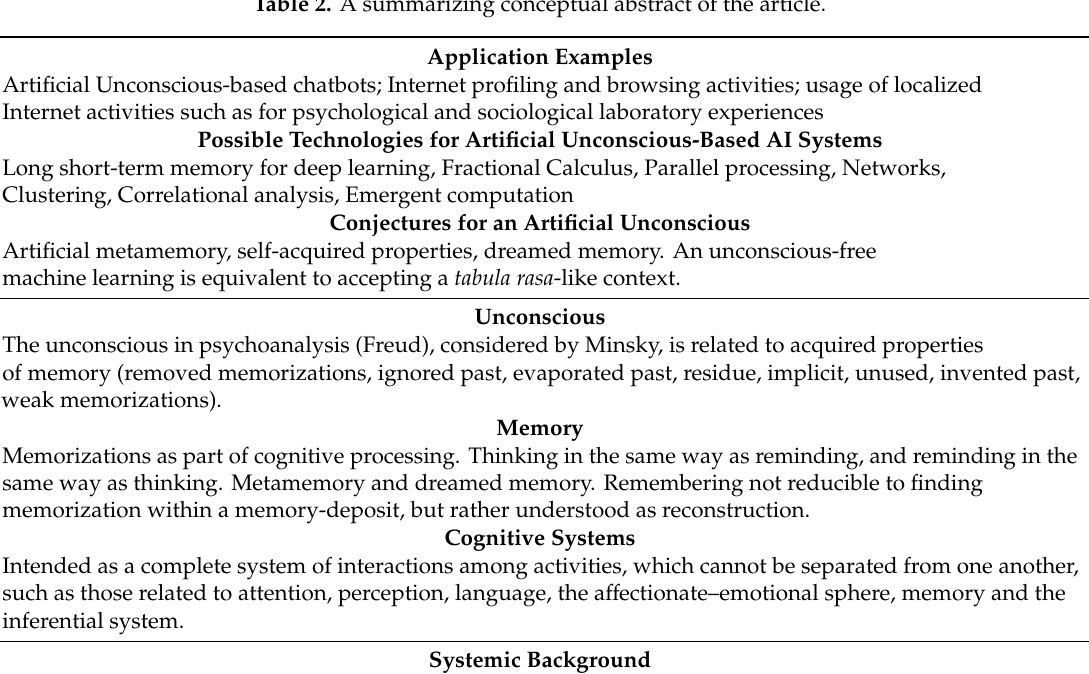
Table 2. A summarizing conceptual abstract of the